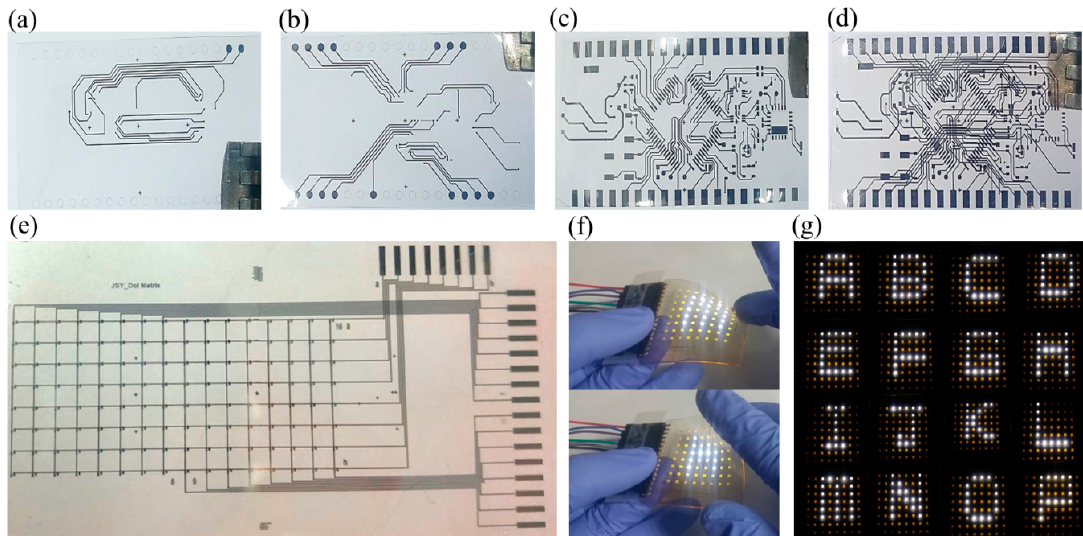
Figure 5. Optical photographs of micro-controller-unit (MCU) board circuit for ( a ) ground (first layer); ( b ) voltage (second layer); ( c ) main (third layer); and ( d ) final circuits fabricated by the multi-layer patterning process on the PI substrate; ( e ) Fabricated dot-matrix circuit using the multi-layer patterning process; ( f ) bending test of the fabricated electric device; ( g ) expression of various capital letters using light emitting diodes (LEDs).